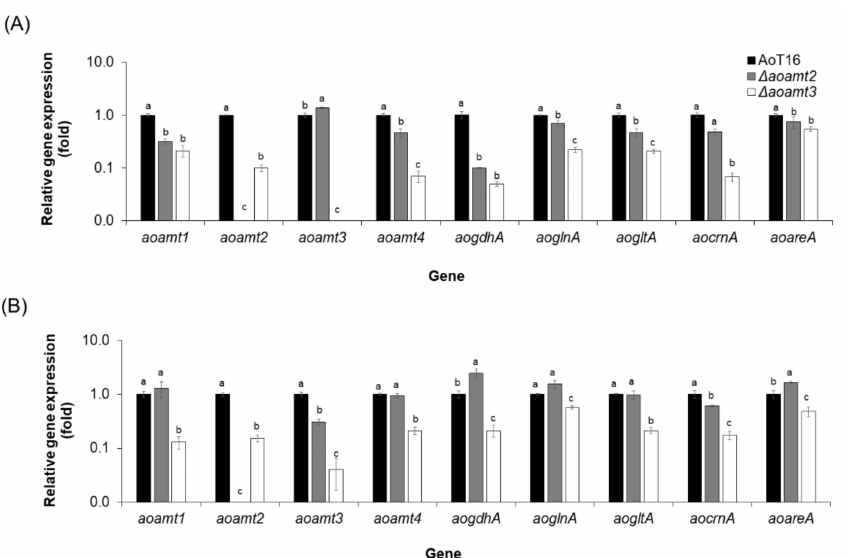
Figure 6. Transcriptional analysis of a set of genes in the A. oryzae -disrupted strains. Expression analysis of aoamt1–4 , aogdhA , aoglnA , aogltA , aocrnA , and aoareA genes of the recipient (AoT16, black bar), ∆ aoamt2 (gray bar) and ∆ aoamt3 (white bar) strains was carried out by RT-qPCR. RNA samples were extracted from the cultures after transferring to a 1 mM NH 4 Cl-containing medium for 1 h ( A ) and 8 h ( B ), which were defined as ammonium deficient and starvation conditions, respectively. The gene expression level in the AoT16 was adjusted to 1 (black bars). Different letters (a, b and c) above the bars indicate a statistically significant difference in the transcript levels of each gene among the three strains analyzed by Duncan’s multiple range test (MRT) ( p value < 0.05). The mean standard deviation (mean SD) of the expression level was derived from triplicate ± ±